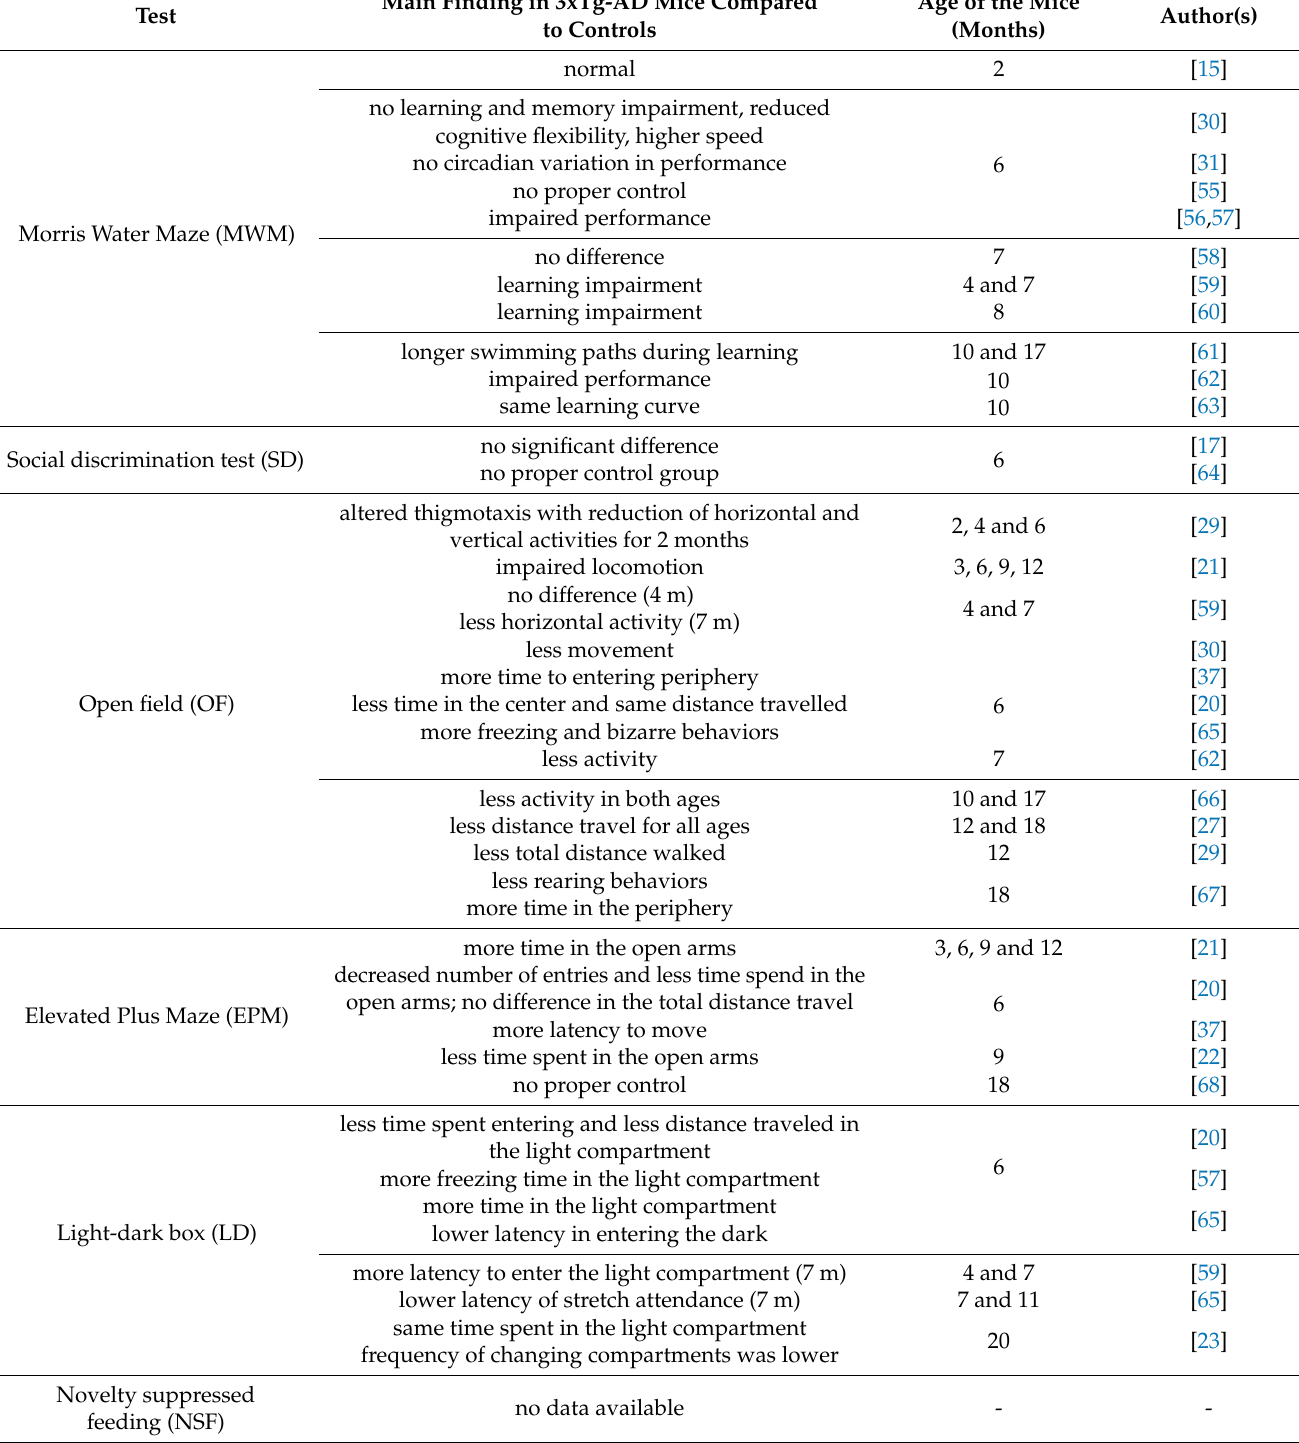
Table A1. Summary of representative literature on the applied behavioral tests in 3xTg-AD mice rep- resenting to present conflicting results. Performance of the 3xTg-AD animals is compared to